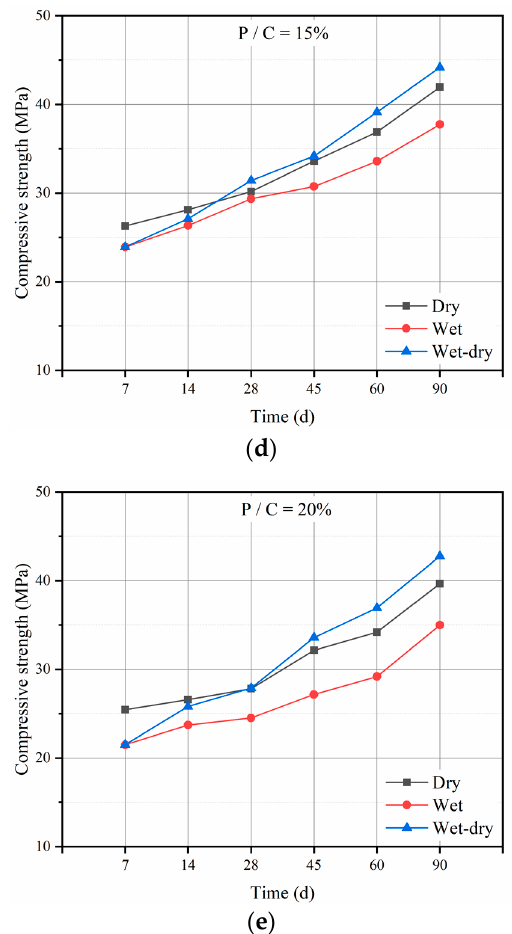
Figure 4. Compressive strength of epoxy latexes modified mortar under three curing regimes: ( a ) 0%, ( b ) 5%, ( c ) 10%, ( d ) 15%, and ( e ) 20%.